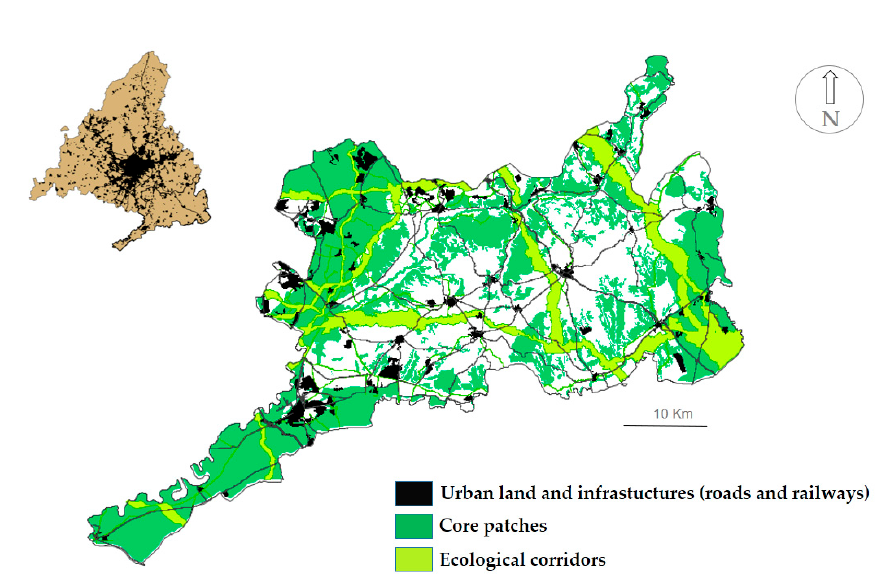
Figure 8. Fragmentation of habitats and loss of ecological connectivity caused by urban development and infrastructure.